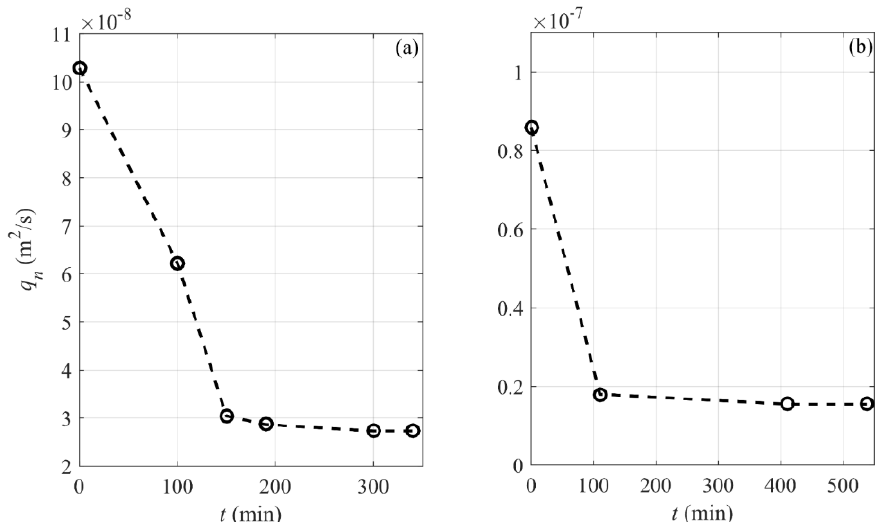
Figure 4. The magnitudes of bed elevation changing rates for case A1_2 ( a ) and E1_1 ( b ).